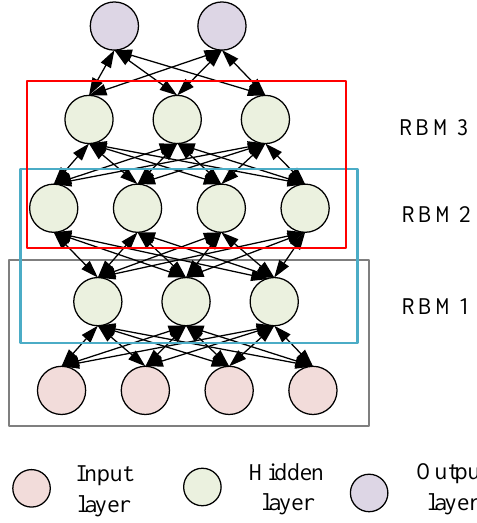
Figure 5. DBN network structure